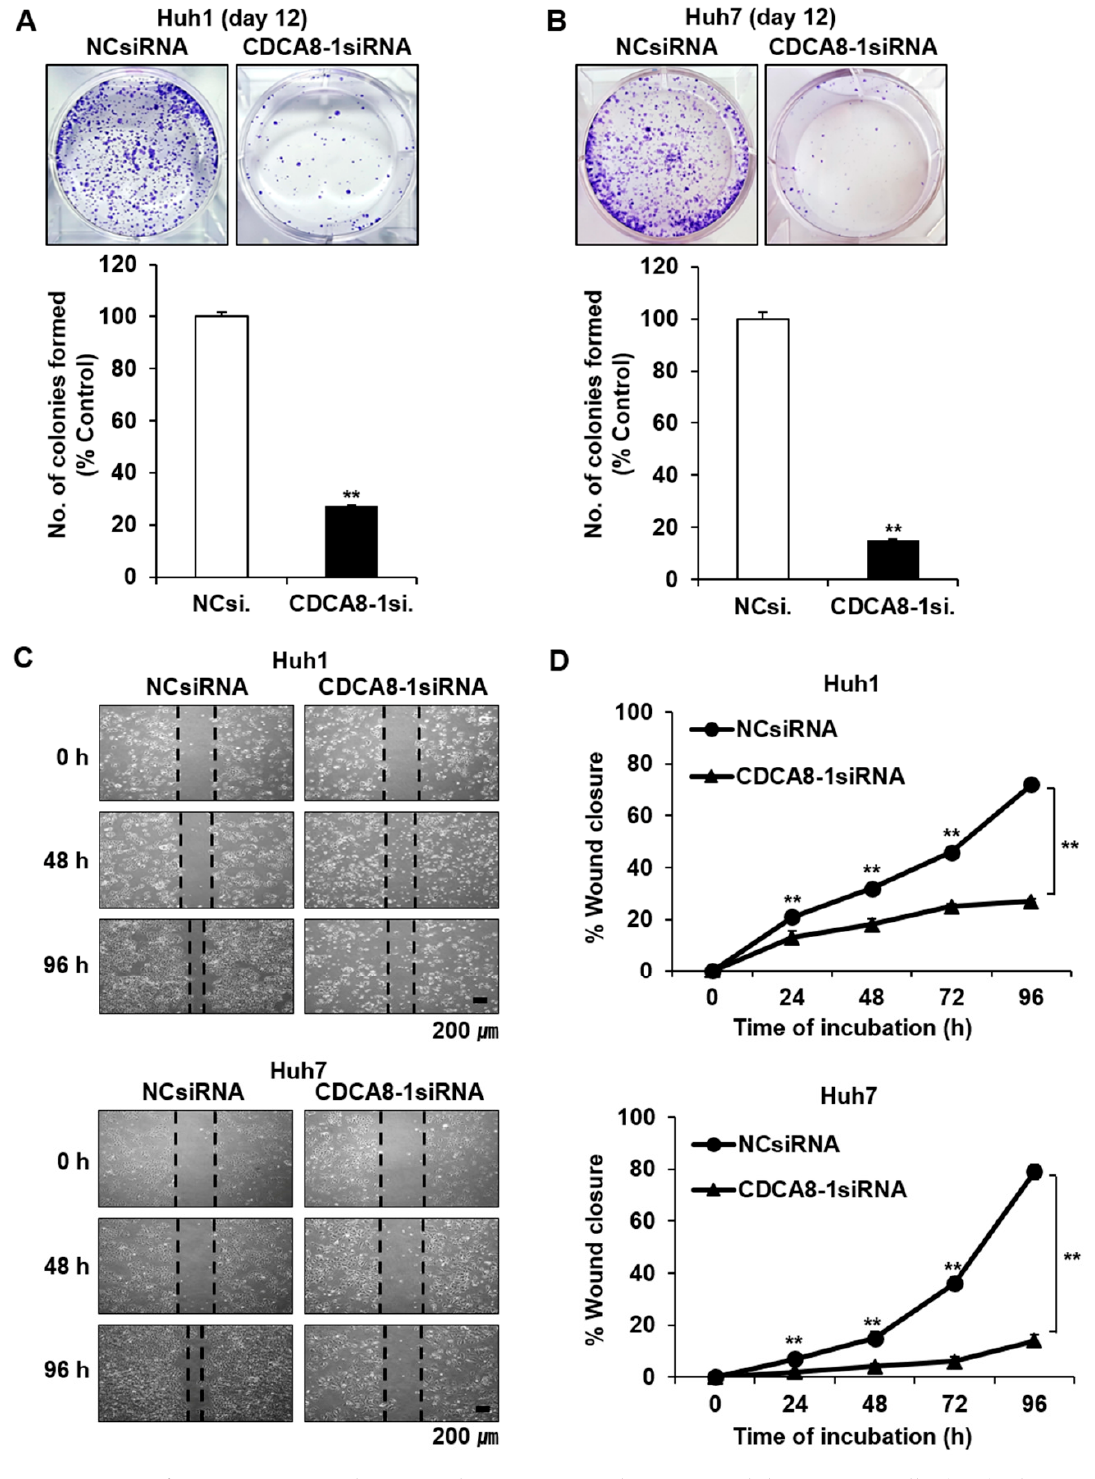
Figure 3. Treatment of CDCA8-1siRNA decreases clonogenicity and migration ability in HCC cells. ( A , B ) Observation of changes in the clonogenicity of Huh1 ( A ) or Huh7 cells ( B ) after 12 days of siRNA treatment. The number of colonies was also measured in each cell line (** p < 0.01, by the Poisson generalized linear model). ( C ) Observation of HCC cell migration using a wound healing assay. Representative images were taken after 0, 48, and 96 h of siRNA treatment. Scale bars, 200 µ m. ( D ) Wound closure was measured daily for up to 4 days and normalized to the time point of day 0 (** p < 0.01 by Bootstrap t -test, n = 3).